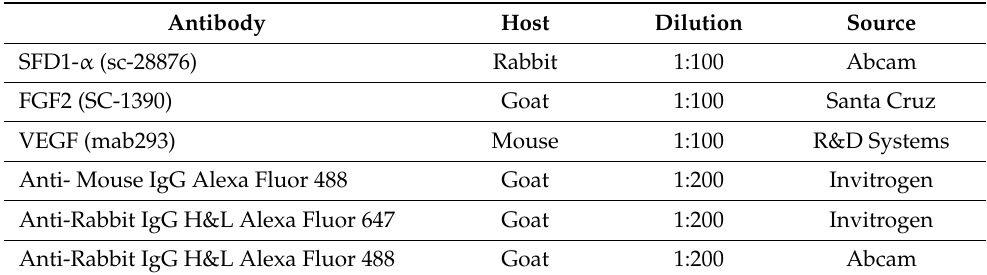
Table 3. Primary and secondary antibodies used in immunofluorescent